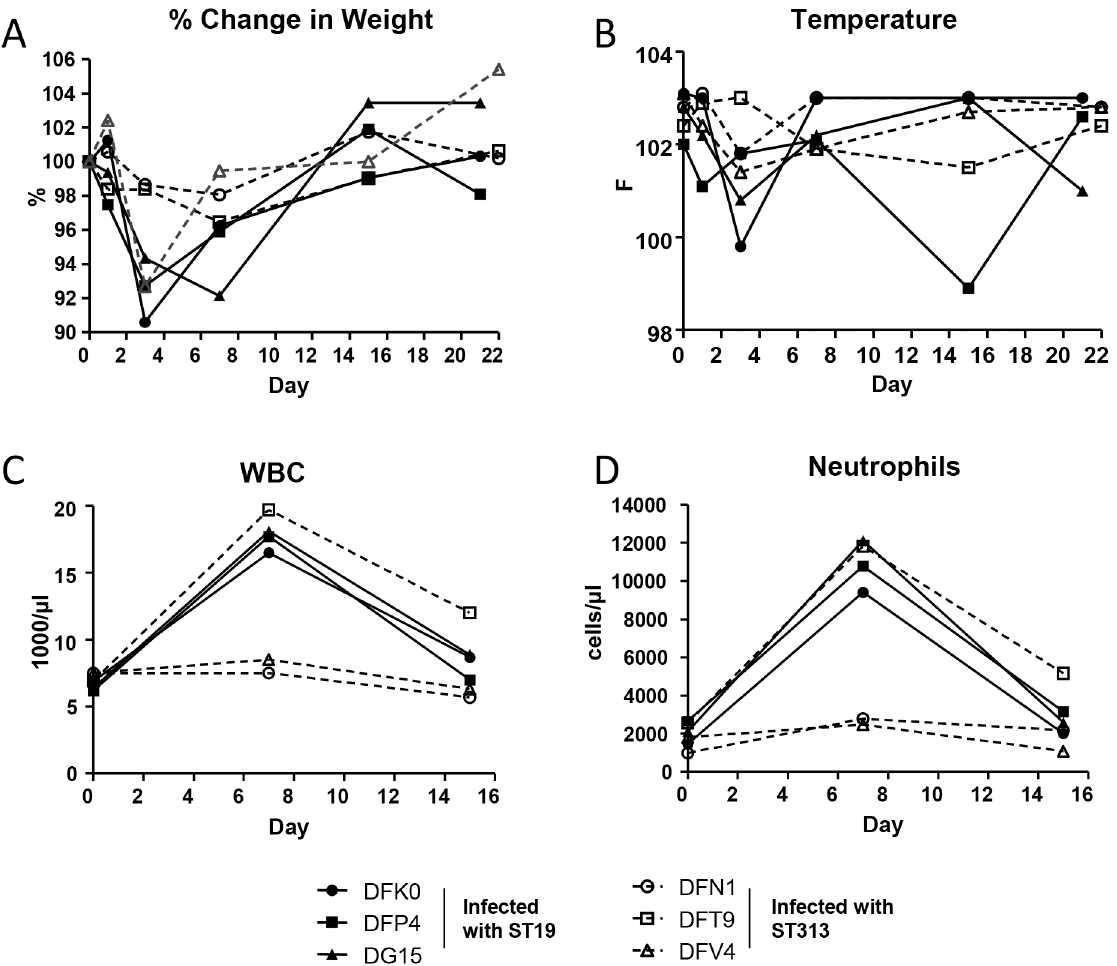
Fig 2. Clinical signs in rhesus macaques. Rhesusmacaquesinfected with Salmonella Typhimurium I77 (ST19) or D65 (ST313) were measuredfor (A) Percent change in weight, and (B) Temperature (in Fahrenheit) on days 1, 3, 7, 15 and 21/22 days post infection. Blood from infected monkeys was collectedon days 0, 7 and 15 and measured for (C) white blood cell (WBC) and (D)